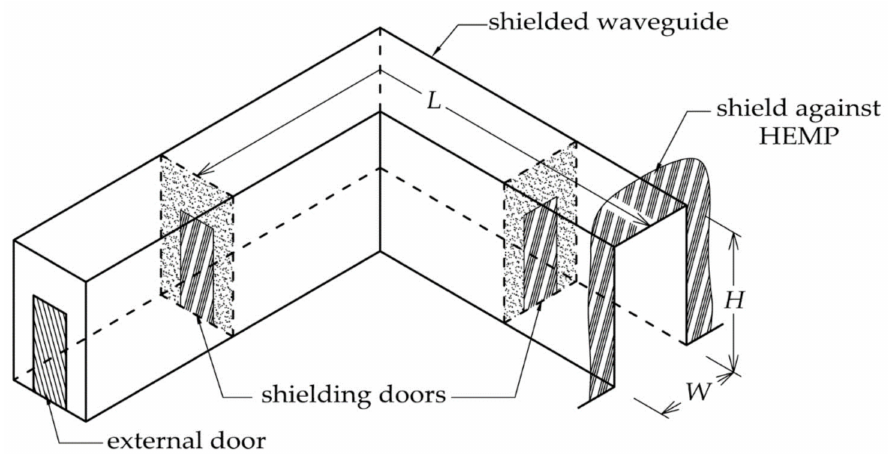
Figure 1. Exemplary structure shielding against high-altitude electromagnetic pulses (HEMP) (after [33]).